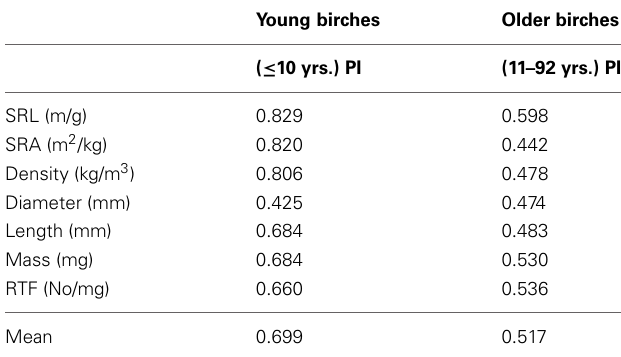
Table 3 | Plasticity indices (PI) of EcM root parameters for the young ( N = 17) and older ( N = 29) age groups of silver birch. Young birches Older